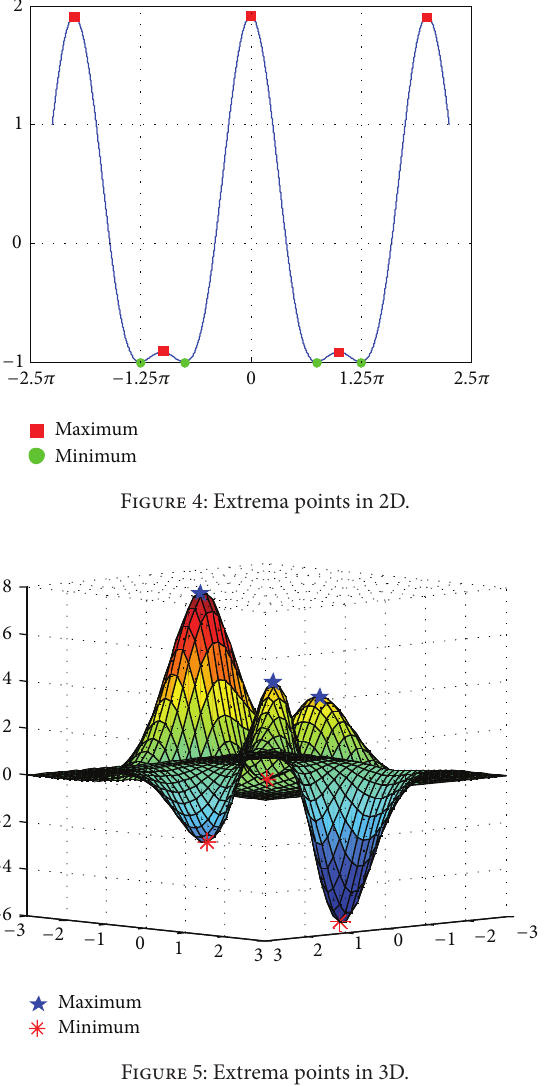
Figure 5: Extrema points in